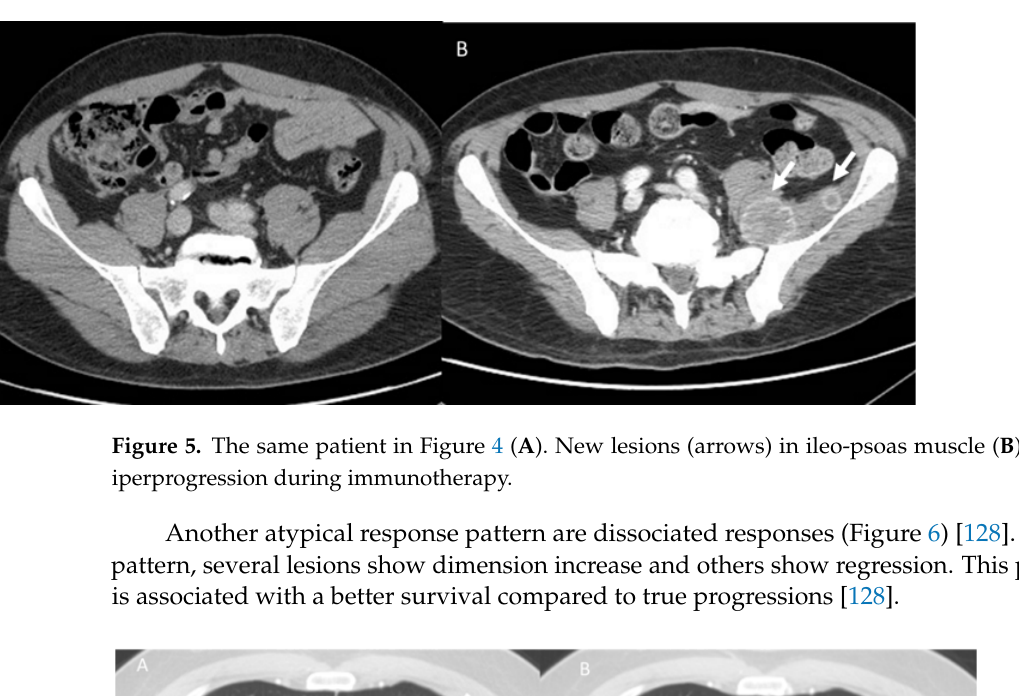
Figure 4. Iperprogression in an NSLC (arrows) patient treated with immunotherapy. CT assessment in pre-treatment phase ( A – C ) and after 3 months ( D – F ).